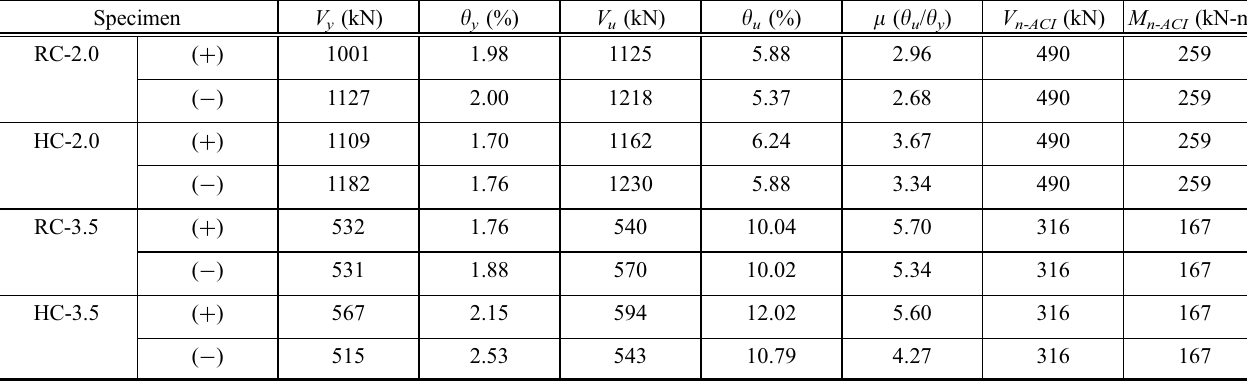
Fig. 10 Hysteretic shear-drift responses. Table 6 Test results for critical strengths and drift